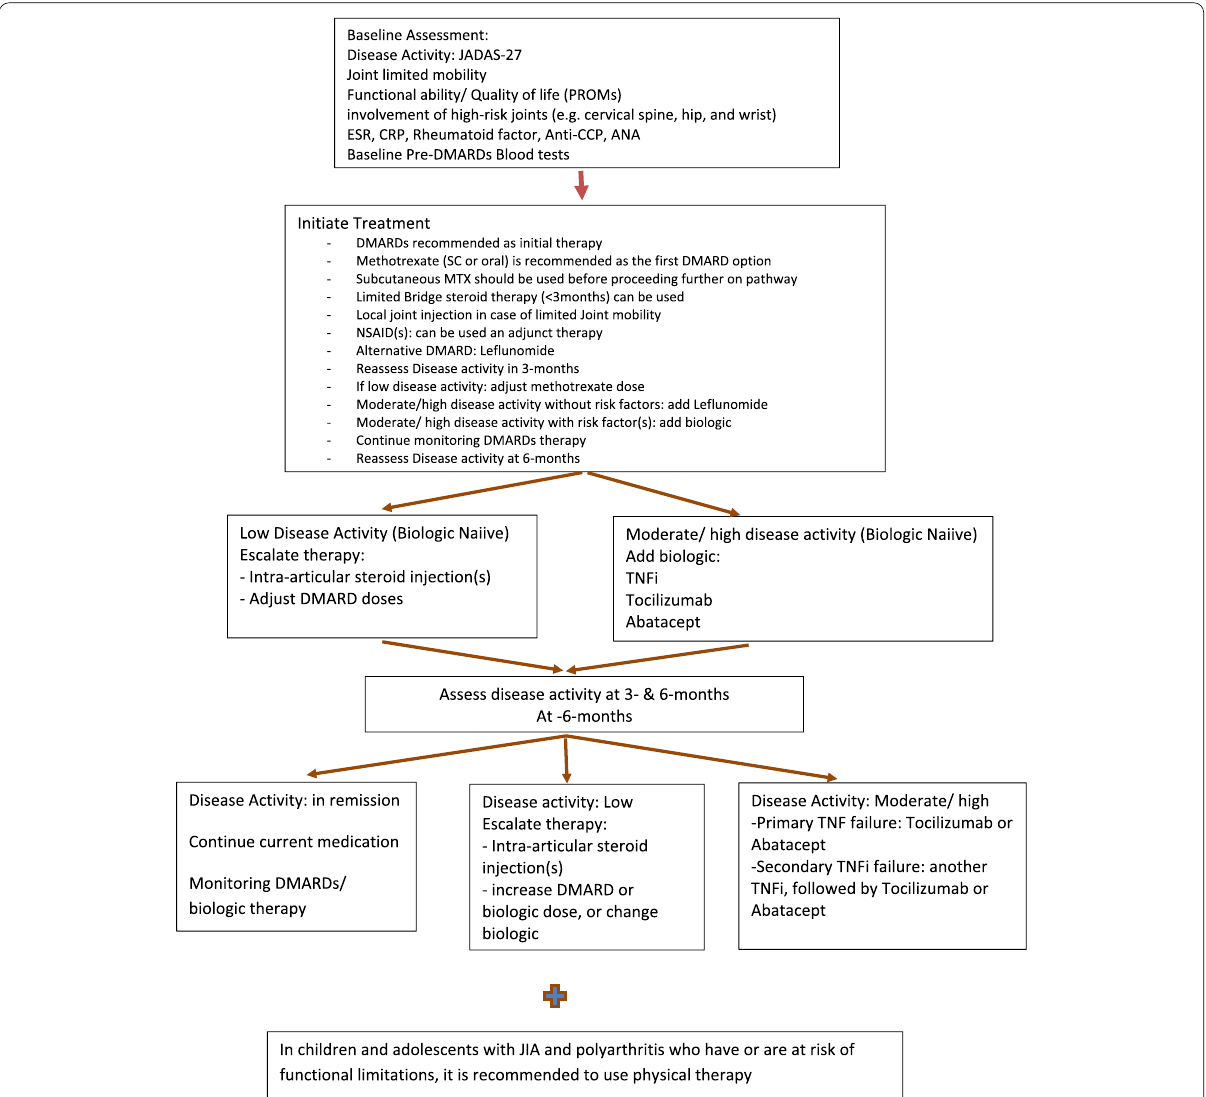
Fig. 2 A summary of primary recommendations for the treat-to-target management of children with juvenile idiopathic arthritis (JIA) and active